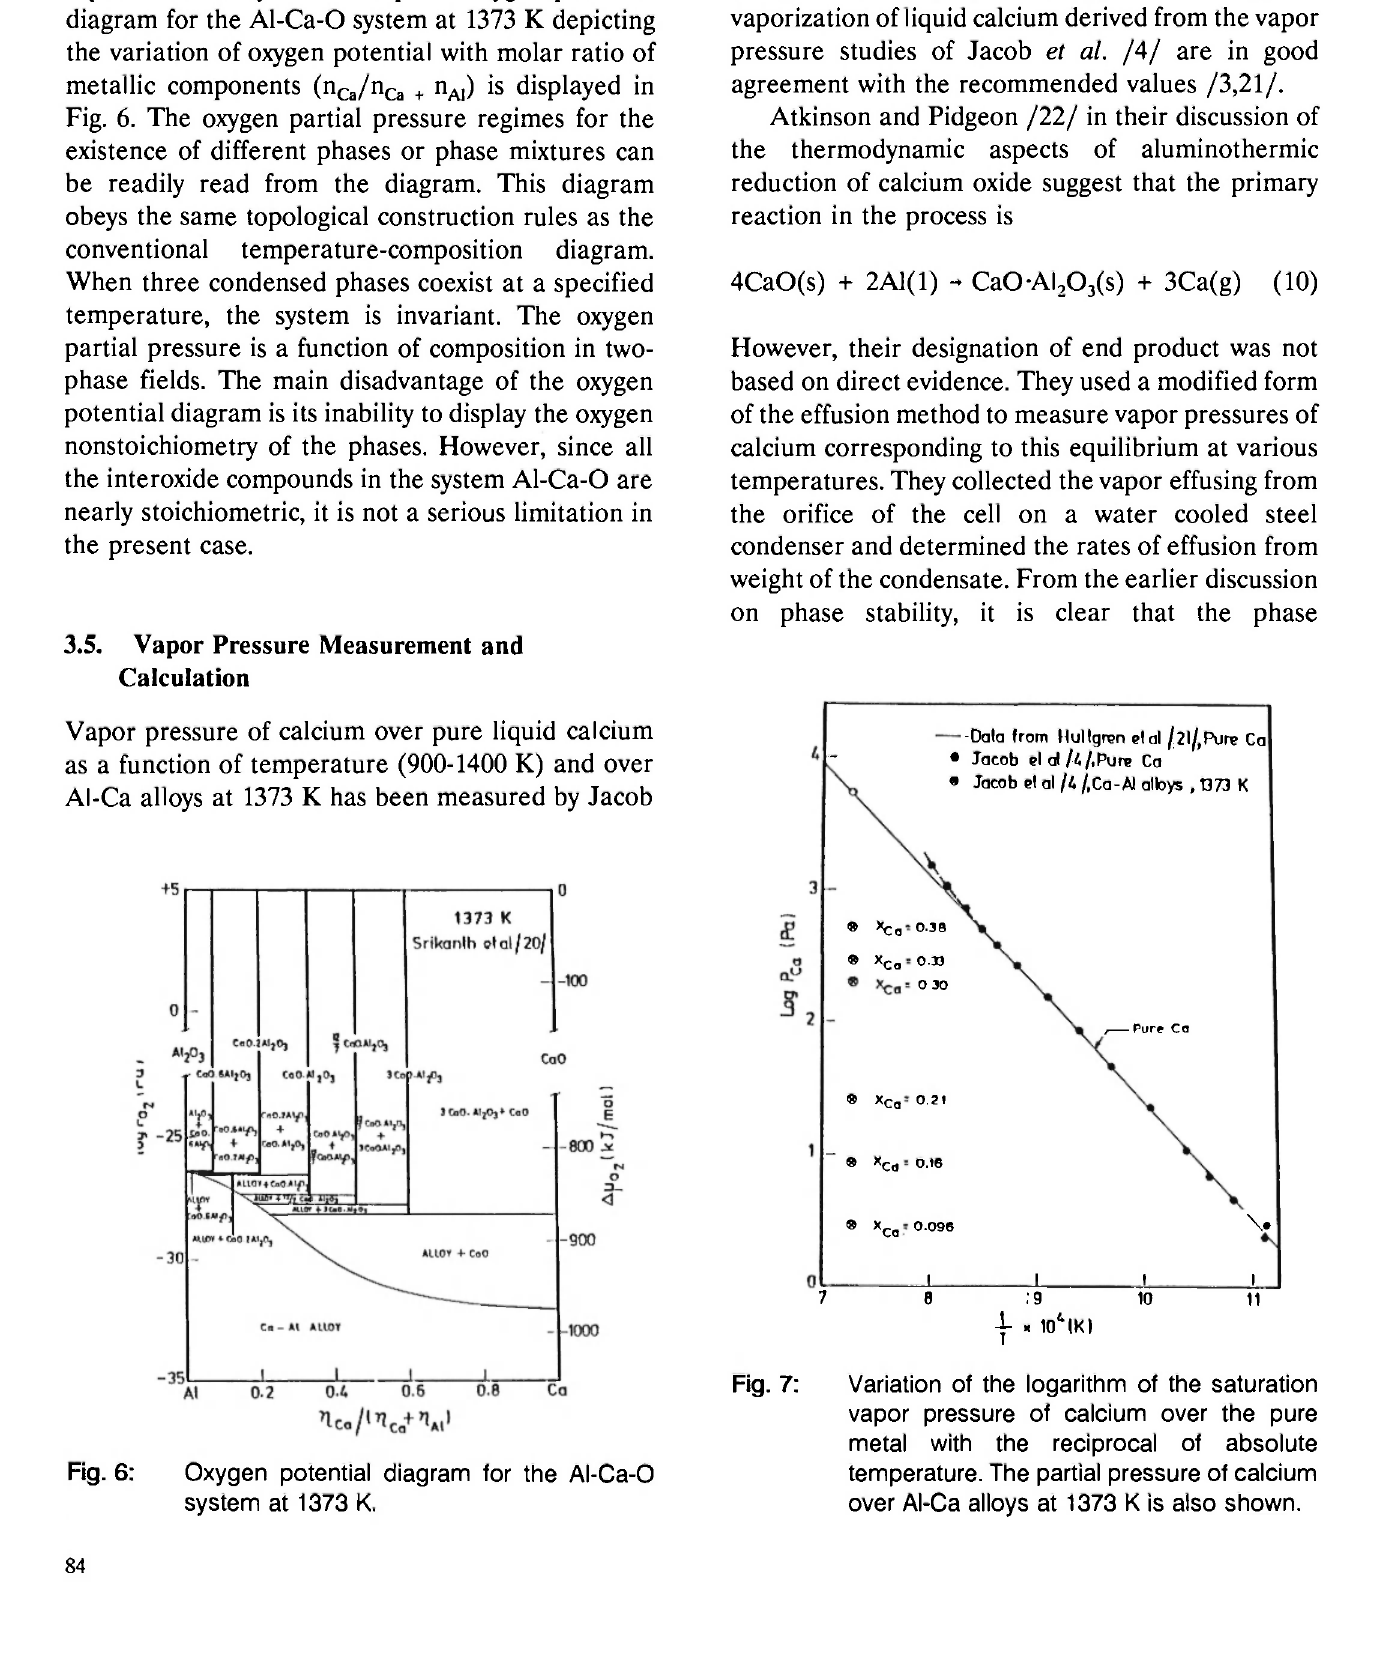
Fig. 7: Variation of the logarithm of the saturation vapor pressure of calcium over the pure metal with the reciprocal of absolute temperature. The partial pressure of calcium over Al-Ca alloys at 1373 Κ is also